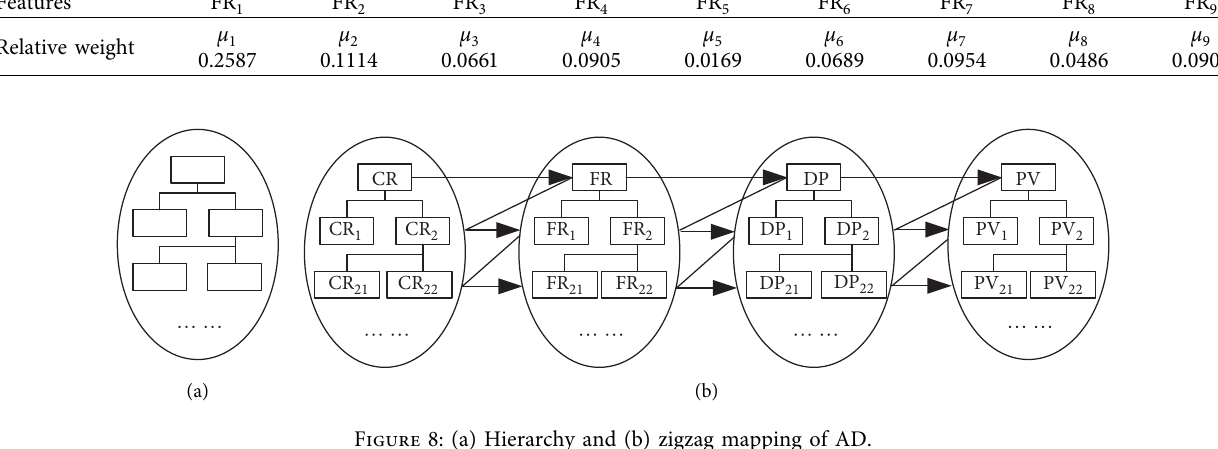
Figure 8: (a) Hierarchy and (b) zigzag mapping of